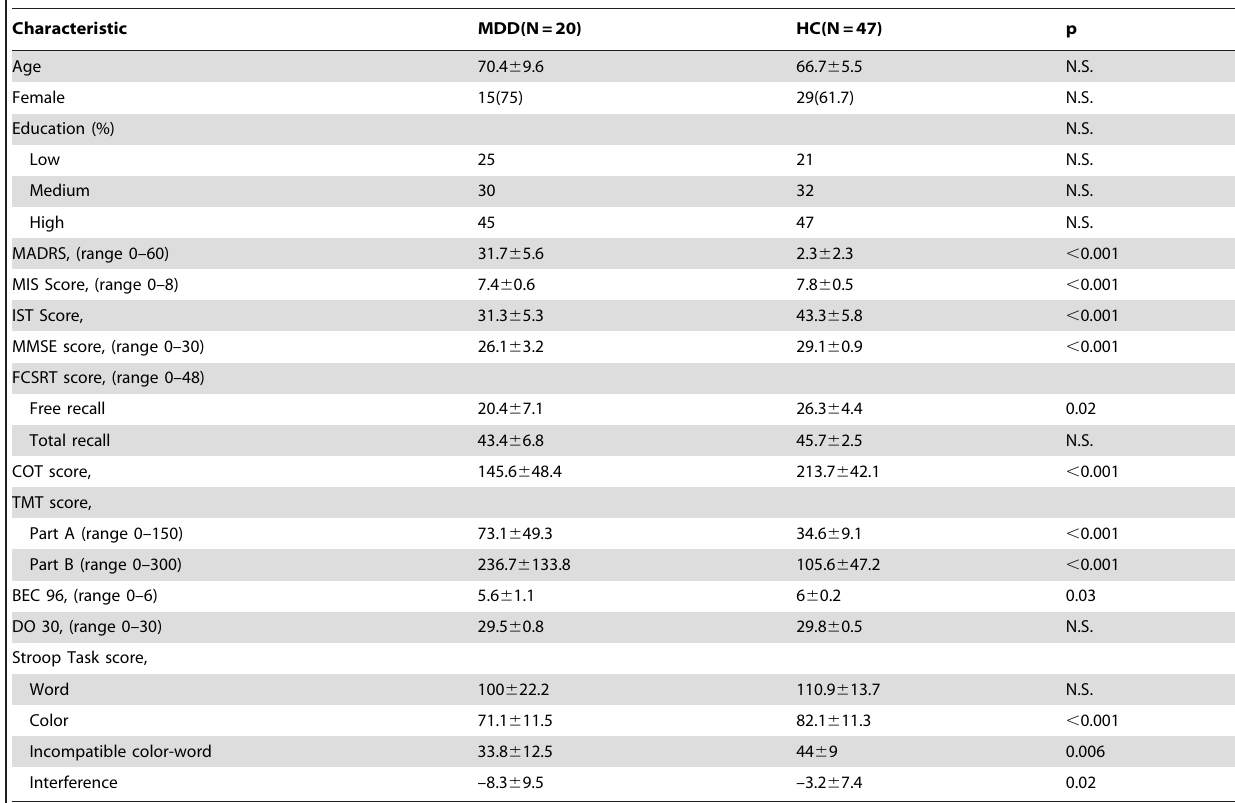
Table 1. Demographic and clinical data.